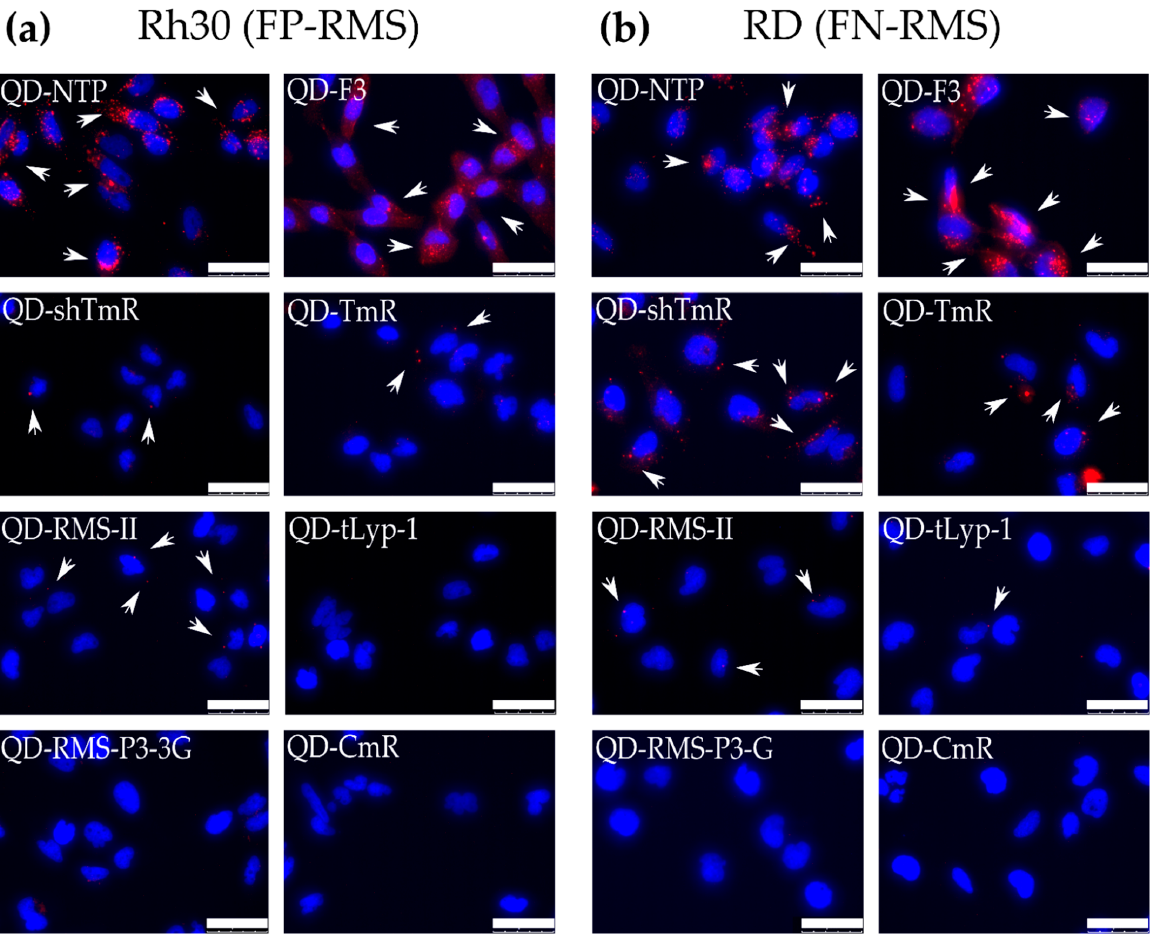
Figure 2. Internalization of QD-peptides conjugates into RMS cell lines. The QD-peptides conjugates that showed a strong biding to RMS cells by FACS were tested by fluorescent microscopy for internalization. ( a ) Rh30 cells and ( b ) RD cells were incubated for 12 h at 37 °C with 20 nM QD- peptides, fixed, and analyzed. CmR peptide was used as a negative control. Scale bars are 50 µm. Blue shows labeling of nuclei with DAPI, red shows QD605. White arrows point to internalized QD aggregates. Scale bar 50 μ m.